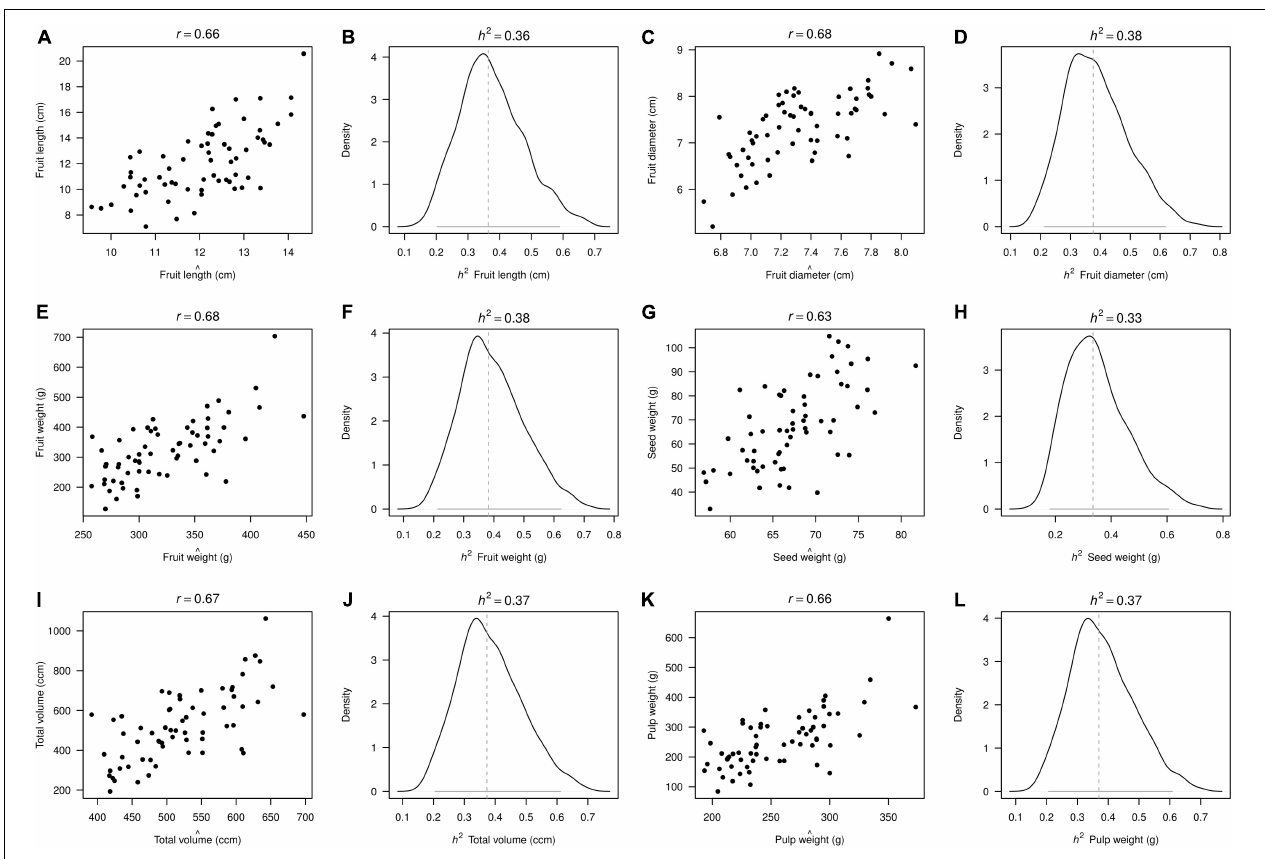
FIGURE 5 | Narrow-sense heritability ( h 2 ) posterior distributions for agronomic traits measured in avocado “criollo” “plus trees” selected as seed donors for rootstocks of the cv. Hass. Model fits are depicted in the odd columns (A,C,E,G,I,K) using Pearson’s correlation r score between the observed (y-axis) and the predicted (x-axis) trait values. Meanwhile, median values (vertical dashed lines) and the 95% confidence intervals (horizontal gray lines) are depicted in the even columns (B,D,F,H,J,L) . Different traits are sorted every second subpanel across rows according to the x-label in each